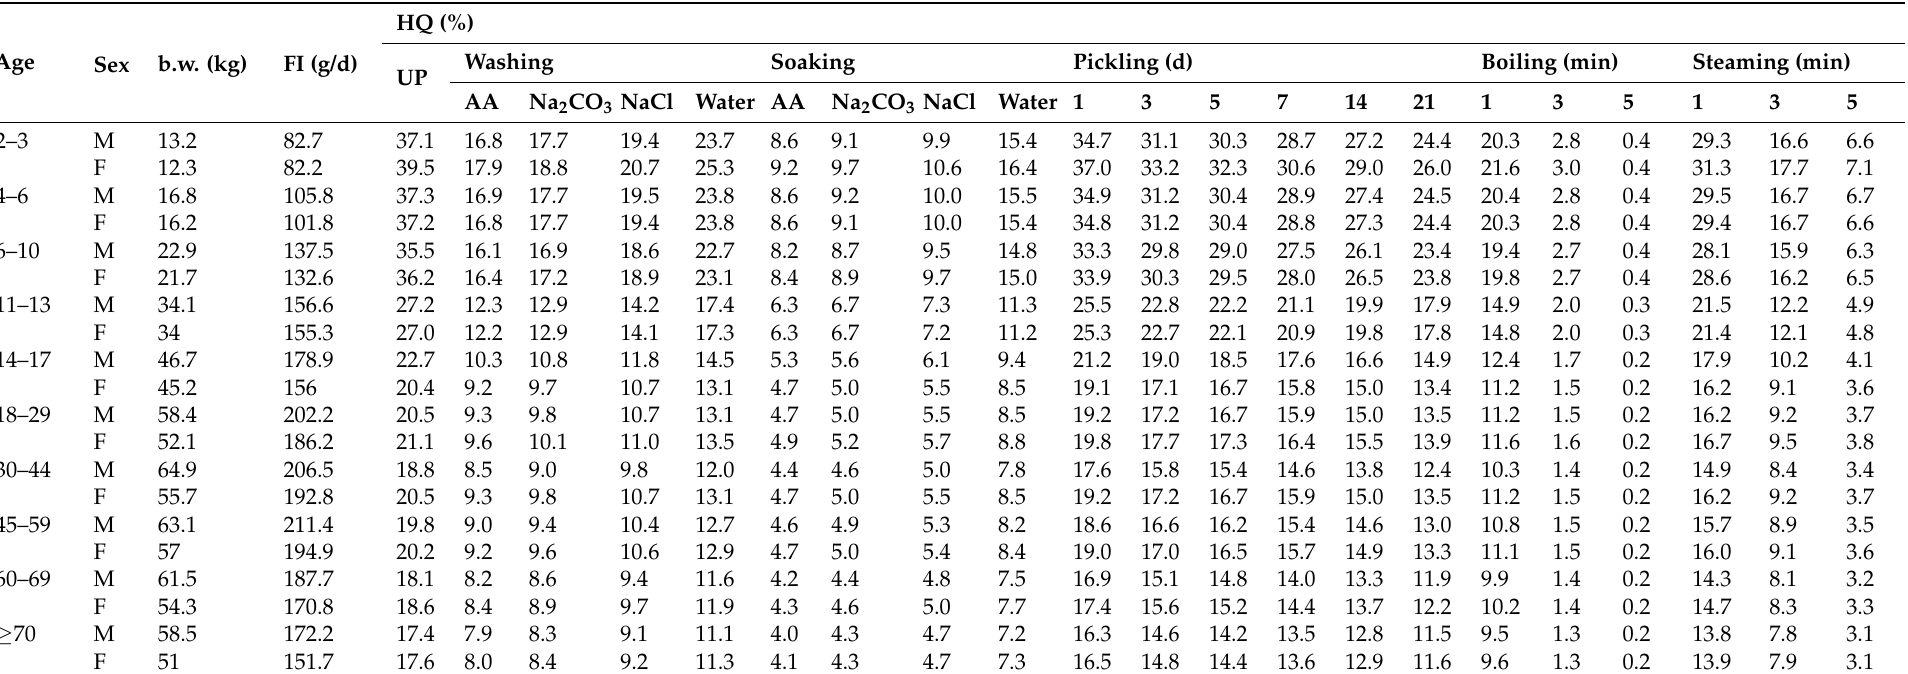
Table 8. Hazard quotient (HQ) of rac -mandipropamid in unprocessed (UP) and processing Chinese cabbage samples for different groups of Chinese